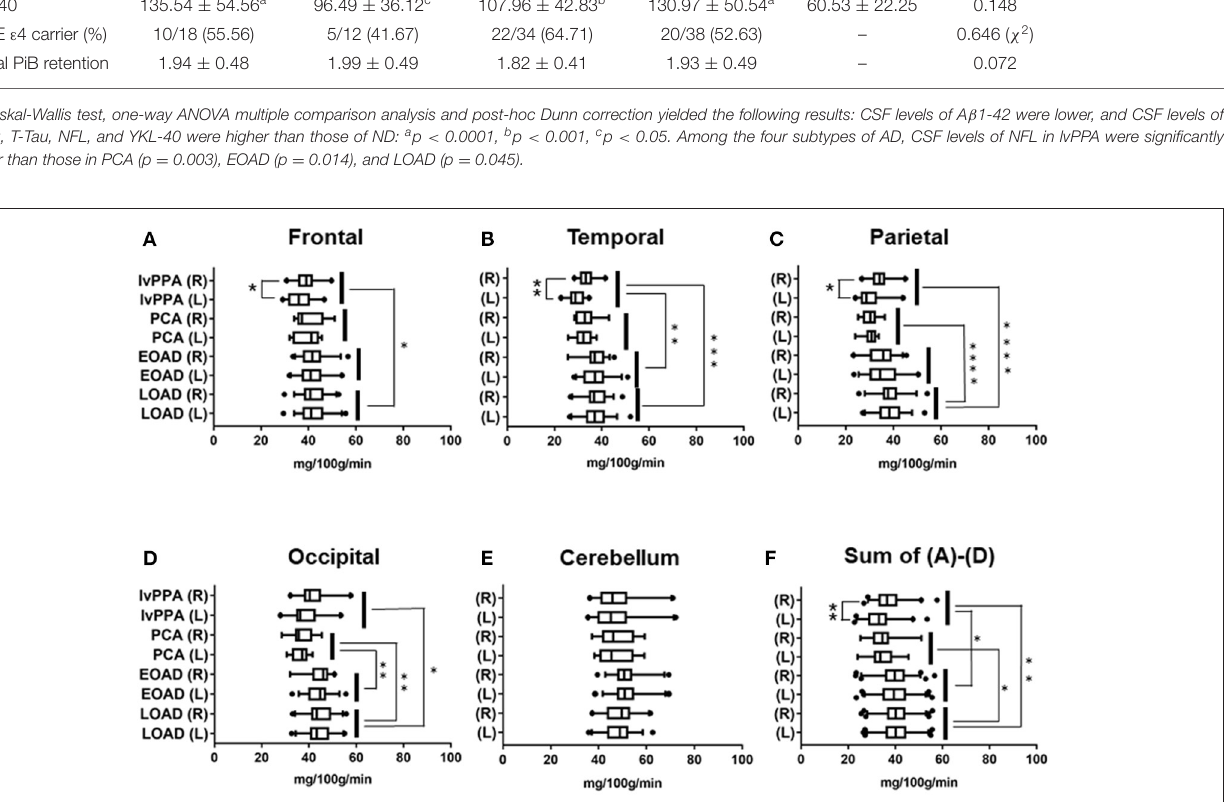
FIGURE 2 | Regional comparison of CBF volumes in the four AD subtypes in 99m Tc ECD-SPECT. CBF volumes in frontal (A) , temporal (B) , parietal (C) , occipital (D) lobes and cerebellum (E) of lvPPA, PCA, EOAD, and LOAD. Total CBF volumes, namely, Sum of (A–D) , in frontal, temporal, parietal and occipital lobes (F) . * p <